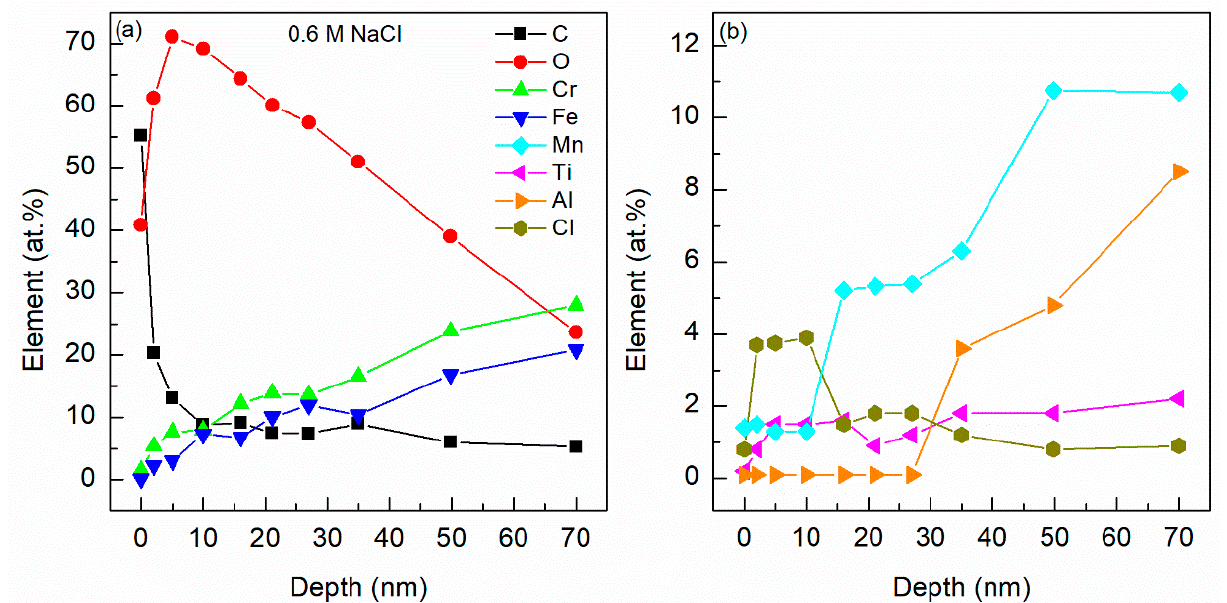
Figure 8. XPS showing depth profiles and elemental analysis (at.%) for Al 10 Cr 30 Fe 25 Mn 30 Ti 5 HEA in 0.6 M NaCl: ( a ) C, O, Cr, Fe, and ( b ) Mn, Ti, Al, and Cl.